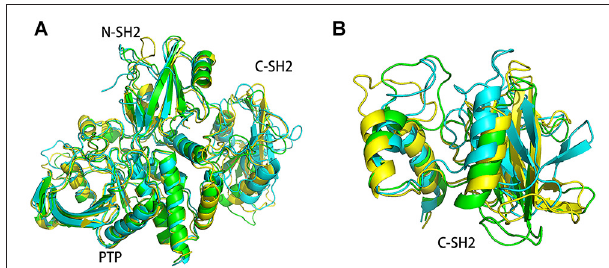
FIGURE 8 | The superimposed structures of system SHP2 (green), DUAL (blue), and the crystal structure (yellow). The superimposed structures of the overall structure (A) and C-SH2 domain were shown separately (B)